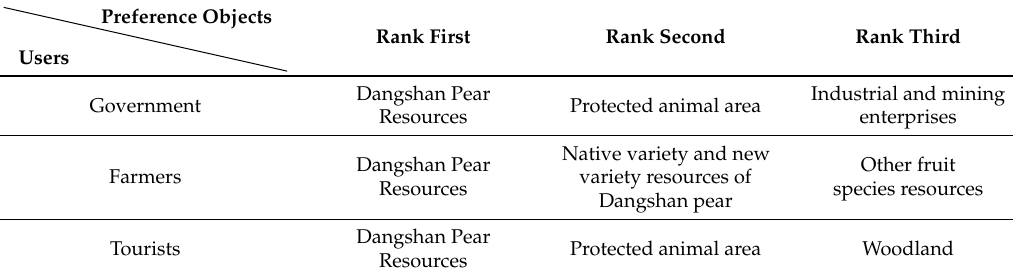
Table 11. First three preference objects of the